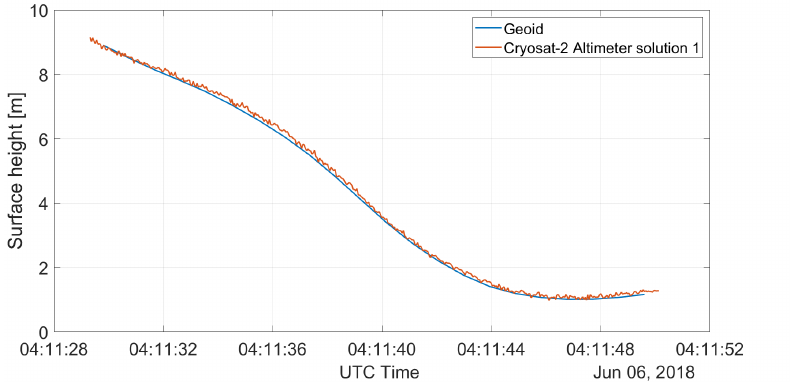
Figure 3. CryoSat-2 altimetry data used as reference ground-truth in this study and geoid (EGM96), both with respect to WGS84. CryoSat-2 flight direction was opposite to the one from the MIR transect